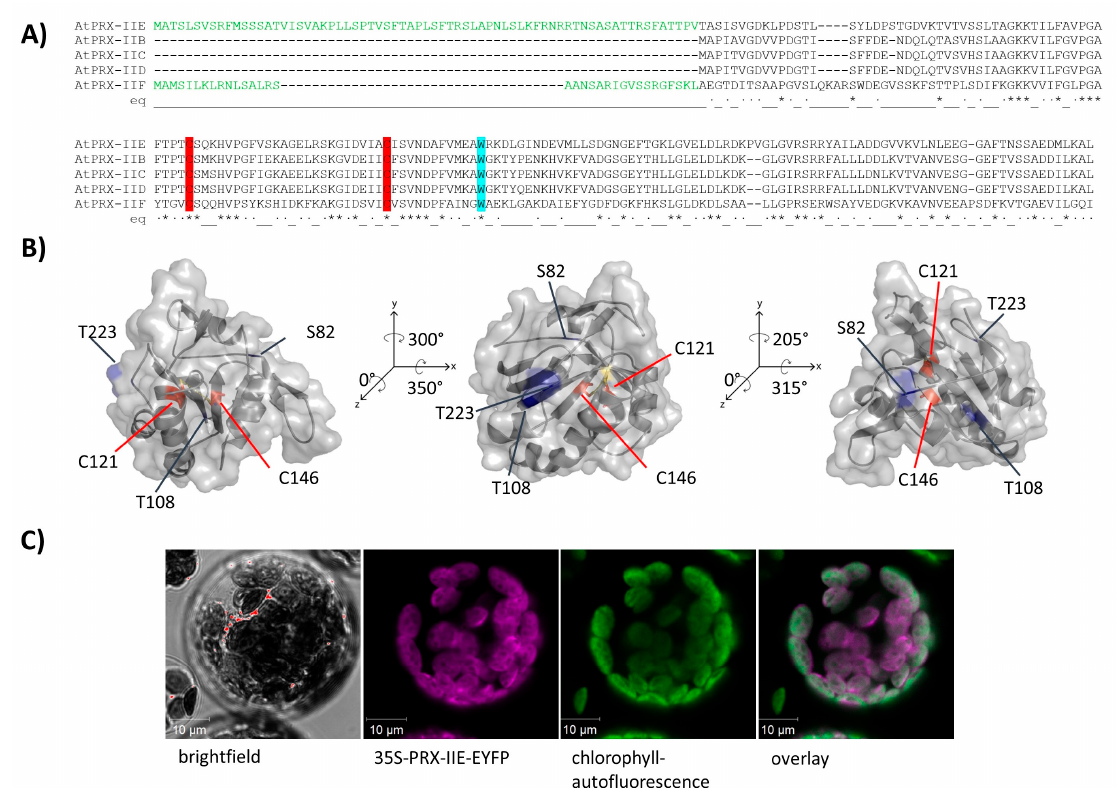
Figure 1. Subcellular localization of PRX-IIE. ( A ) Amino acid sequence alignment of A. thaliana type II PRXs. The signal peptides of PRX-IIE and PRX-IIF are highlighted in green as well as the highly conserved cysteines (C: red) and tryptophan (W: blue). ( B ) Predicted 3D structure of mature PRX-IIE from three different points of view. The model is based on the PRX D type II from P. tremula (pdb:1tp9A) and further analysis was done using PyMOL 2.4. Both cysteines, C121 and C146 are marked in red, whereas the putative phosphorylation sites S82, T108, and T223 are marked in blue. The distance between the cysteines is 7.83 Å. The accessible surface area of the peroxidatic cysteine at position 121 is 0.795 Å 2 . ( C ) The coding sequence of PRX-IIE was fused in-frame to EYFP as a reporter and used for transient expression in A. thaliana mesophyll protoplasts. Confocal laser scanning images revealed chlorophyll autofluorescence (green) and fluorescence of the PRX-IIE-EYFP construct (purple). White areas in the overlay indicate chloroplastic localization of